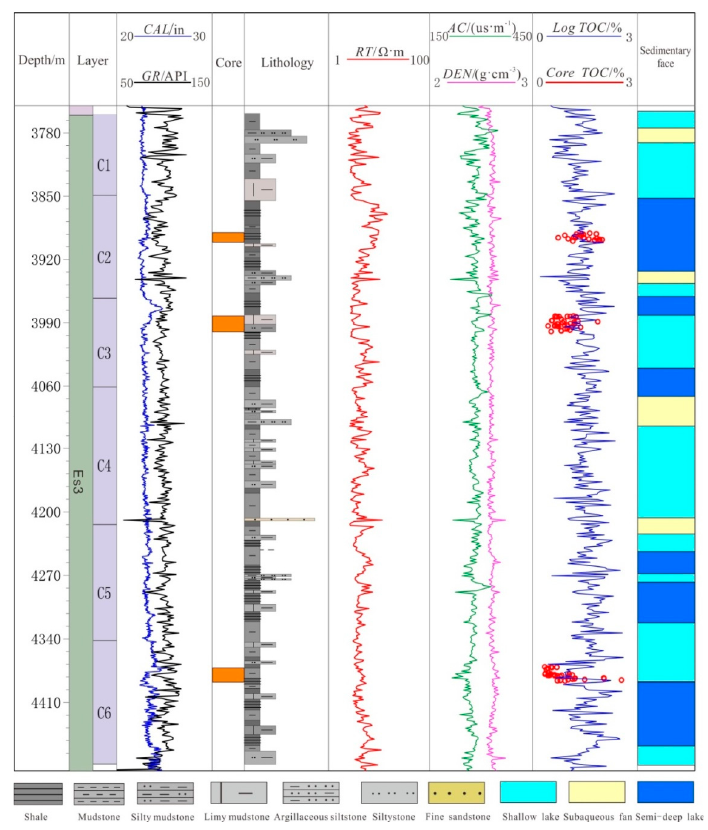
Figure 2. Comprehensive stratigraphic histogram of upper part of Es3 in well F39x1.